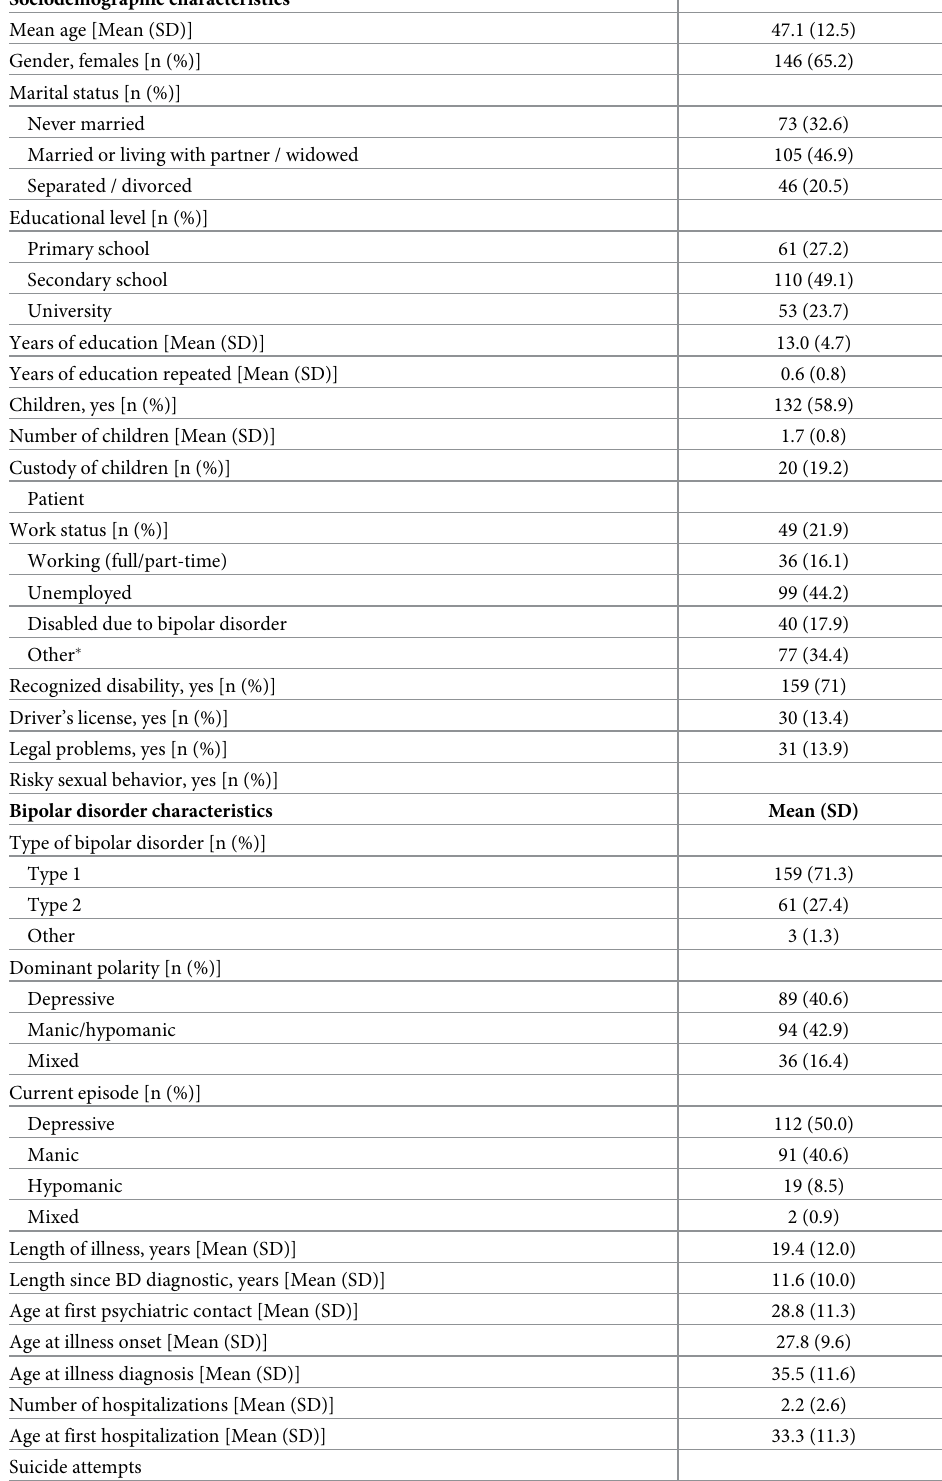
Table 1. Patient sociodemographic and clinical